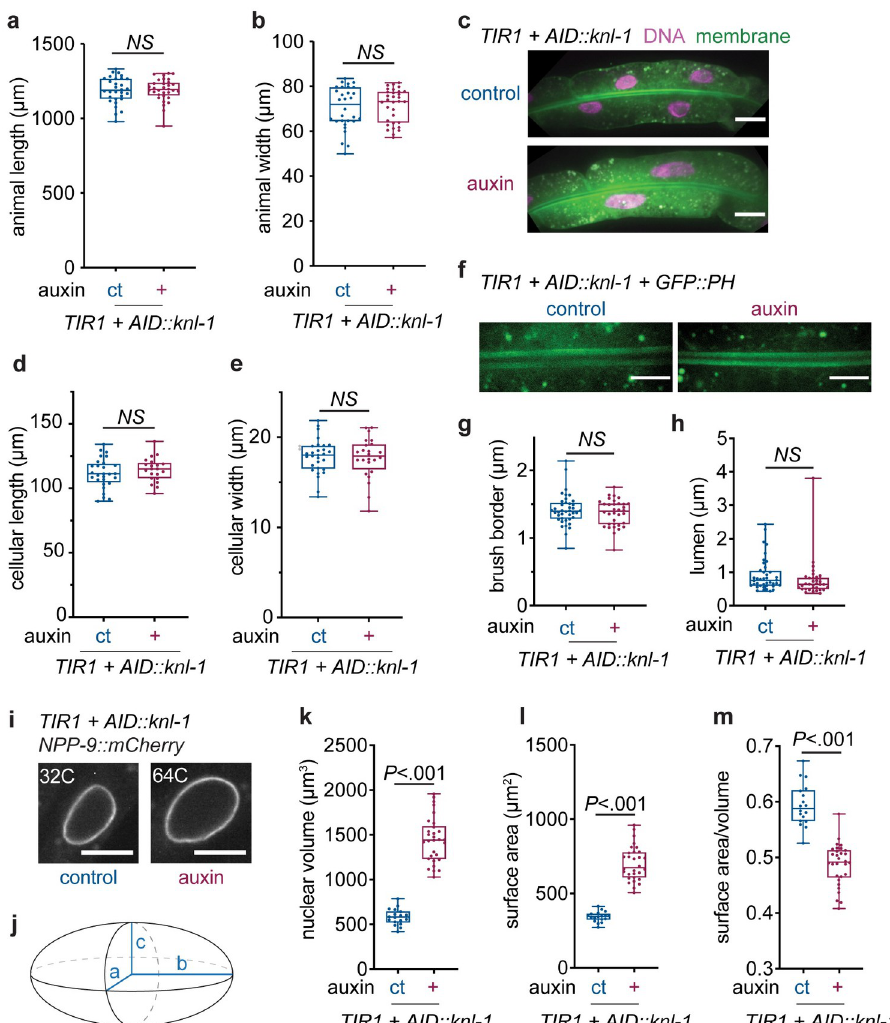
Fig 2. Intestinal cell mononucleation does not influence worm size, cell size, or intestinal morphology, but generates nuclei that are more than twice as big. (A, B) Total body length (A) and width (B) of Pges-1 :: TIR1; AID :: knl-1 young adults grown under control conditions (ct, n = 30) or in the presence of auxin (+, n = 32). Boxplots indicate the median and 25th to 75th percentile, error bars indicate min to max values, and individual values are shown as dots. NS, not significant ( P > 0.05, Student t test). (C) Representative Z-stack projections of intestinal H2B- mCherry (DNA) and GFP-PH (membrane) in intestinal ring 3 of Pges-1 :: TIR1; AID :: knl-1 animals grown on auxin or control conditions, used for quantifications of cell length and width. Scale bar is 20 μ m. (D, E) Cellular length (D) and width (E) of Int3D/V cells of Pges-1 :: TIR1; AID :: knl-1 young adults grown under control conditions (ct, n = 58) or in the presence of auxin (+, n = 24). Boxplots indicate the median and 25th to 75th percentile, error bars indicate min to max values, and individual values are shown as dots. NS, not significant ( P > 0.05, Student t test). (F) Representative Z-stack projections of intestinal GFP-PH (membrane) in the apical membrane of intestinal ring 3 of Pges-1 :: TIR1; AID :: knl-1 animals that were grown under control conditions or in the presence of auxin, used for quantifications of brush border and luminal width. Scale bar is 10 μ m. (G, H) Intestinal brush border (G) and lumen (H) width in intestinal ring 3 of young adult worms grown under control (ct, n = 40) or auxin (+, n = 34) conditions. Boxplots indicate the median and 25th to 75th percentile, error bars indicate min to max values, and individual values are shown as dots. NS, not significant ( P > 0.05, Mann–Whitney test). (I) Fluorescent images of intestinal NPP-9:: mCherry localization in the nuclear membranes of Int3 cells of Pges-1 :: TIR1; AID :: knl-1 adults grown under control or auxin conditions, corresponding to a 32C and 64C DNA content, respectively. Scale bar represents 10 μ m. (J) Schematic depicting an ellipsoid shape and radii a, b, and c used to calculate nuclear volume and surface area. (K–M) Boxplots depicting the average nuclear volume (K), surface area (L) and surface-area-to-volume ratio (M) in binucleated (ct, n = 60 cells, 18 animals) or mononucleated (+, n = 56 cells, 30 animals) cells of Pges-1 :: TIR1; AID :: knl-1 animals. Boxplots indicate the median and 25th to 75th percentile, error bars indicate min to max values, and individual values are shown as dots. P values were calculated by Mann–Whitney (K, L) or unpaired Student t test (M). Underlying data can be found in S1 Data. AID, auxin-inducible